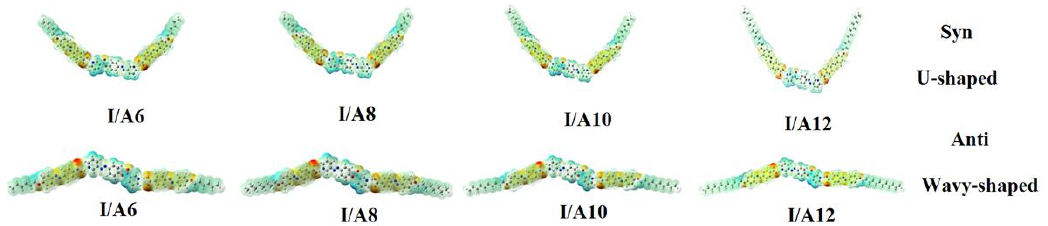
Figure 4. Molecular electrostatic potentials (MEP) of both conformers of the H-bonded complexes I / An .